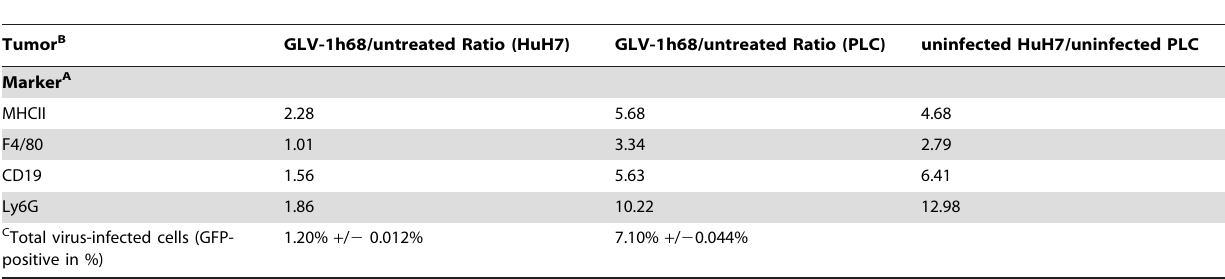
A Markers: MHCII-PE antibody detects a polymorphic determinant present on B cells, monocytes, macrophages and dendritic cells. F4/80-APC antibody recognises the F4/80 antigen, that is expressed by a majority of mature macrophages and is the best marker for this population of cells. CD19 is expressed on B cells and follicular dendritic cells. Ly6G-PE, also known as Gr-1- antigen, is expressed on mouse neutrophils, predominantly granulocytes. B Single cell suspensions derived from infected and uninfected HuH7 and PLC tumors 7dpi (n=4 for uninfected and n=3 for virus-infected groups) were used for FACS characterization. Ratios greater than 1 indicate an increased accumulation of host immune cells. C GFP-positive cells of the infected tumors were presented as mean values (n=3) + / 2 standard deviations in percentages.